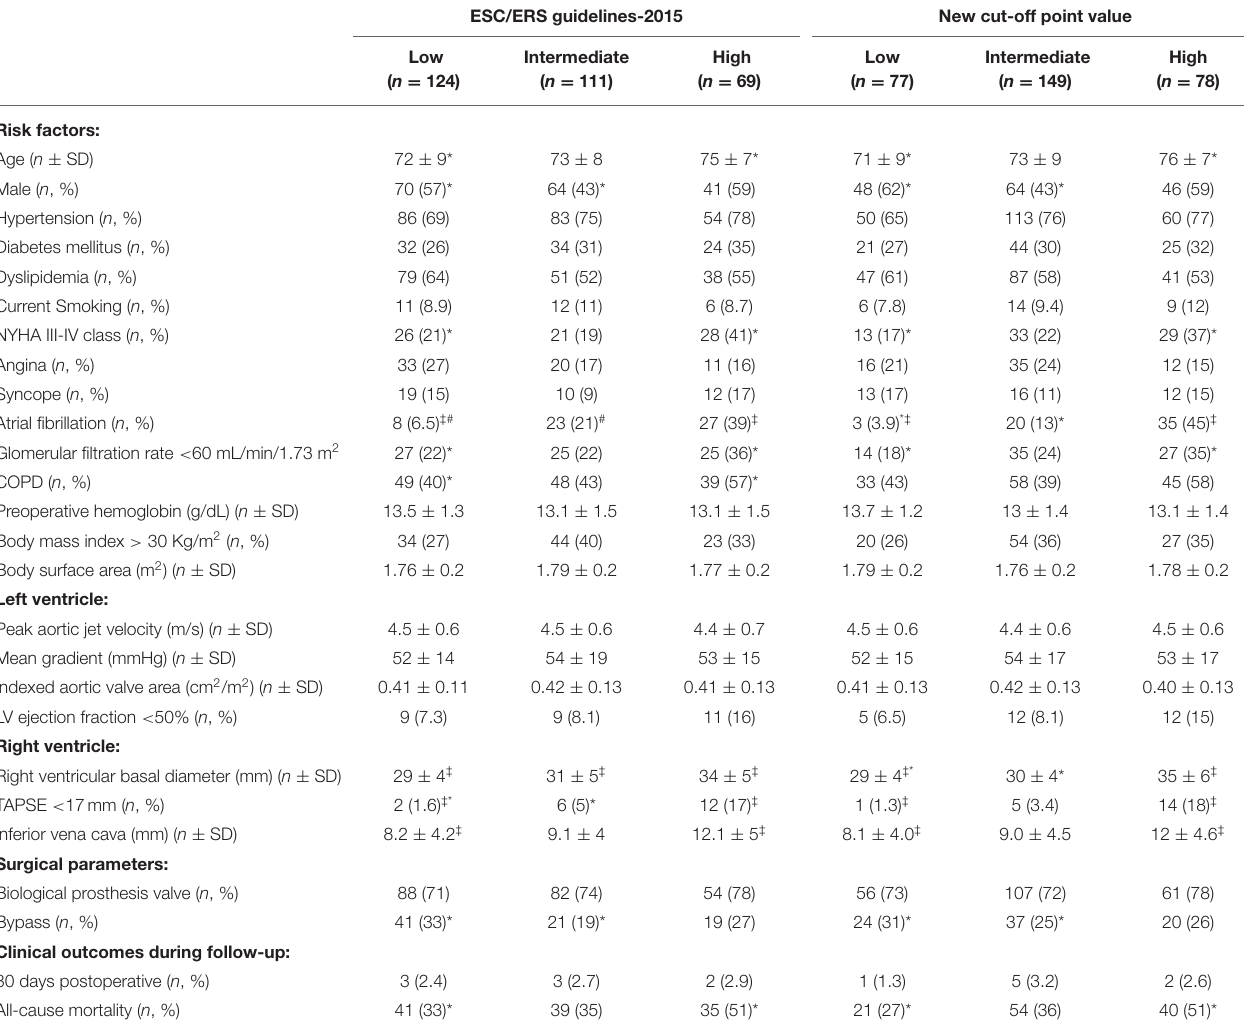
TABLE 2 | Baseline characteristics and all-cause mortality during follow-up between groups, according to current ESC/ERS guidelines and the new cut-off point thresholds, in patients with tricuspid regurgitation. ESC/ERS